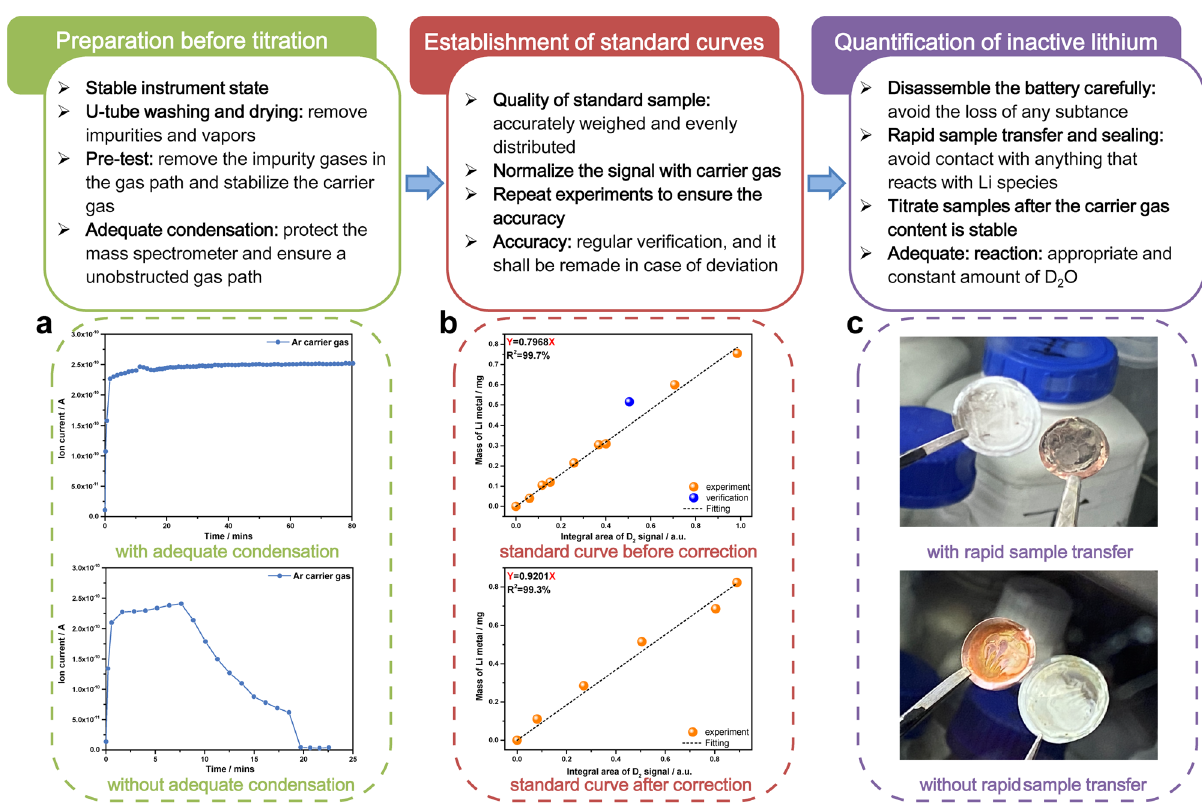
Fig. 2 All points for attention and a complete protocol for reproducible MST results. a With/without adequate condensation. b The Li metal standard curve before/after correction. c With/without rapid sample transfer.